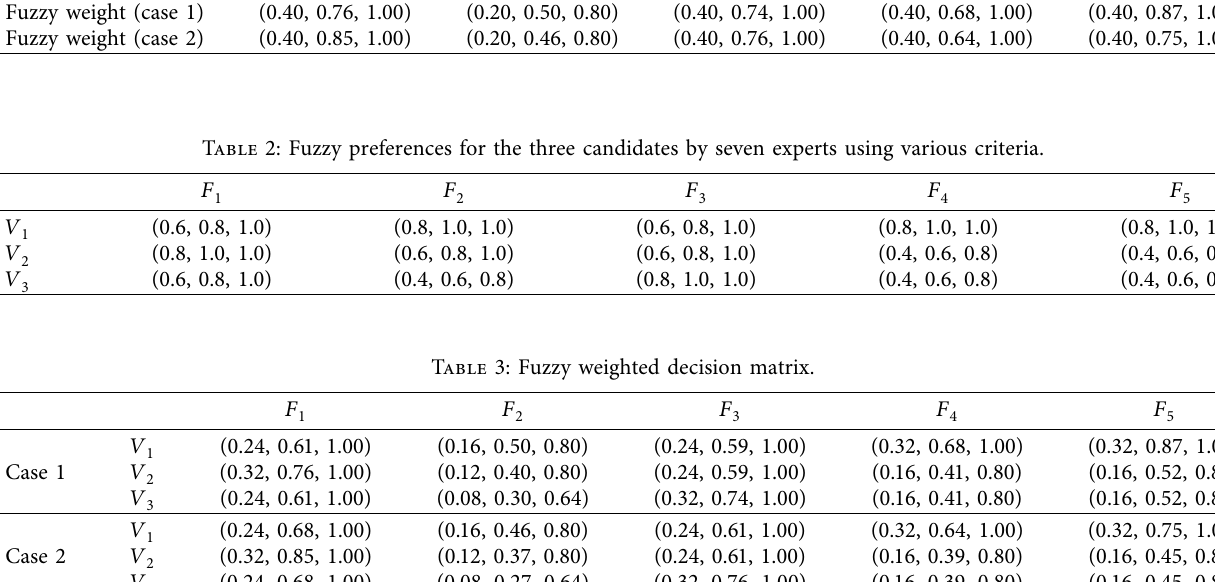
( i � 1 , 2 , 3 ) and V ∗ ( V − ) with respect i